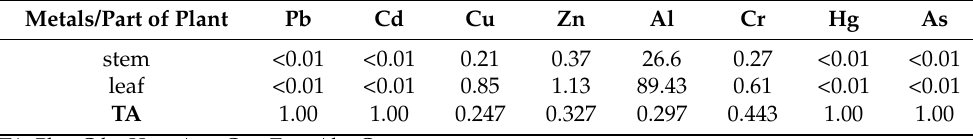
Table 7. Translocation ability, water chestnut, stem-leaf.